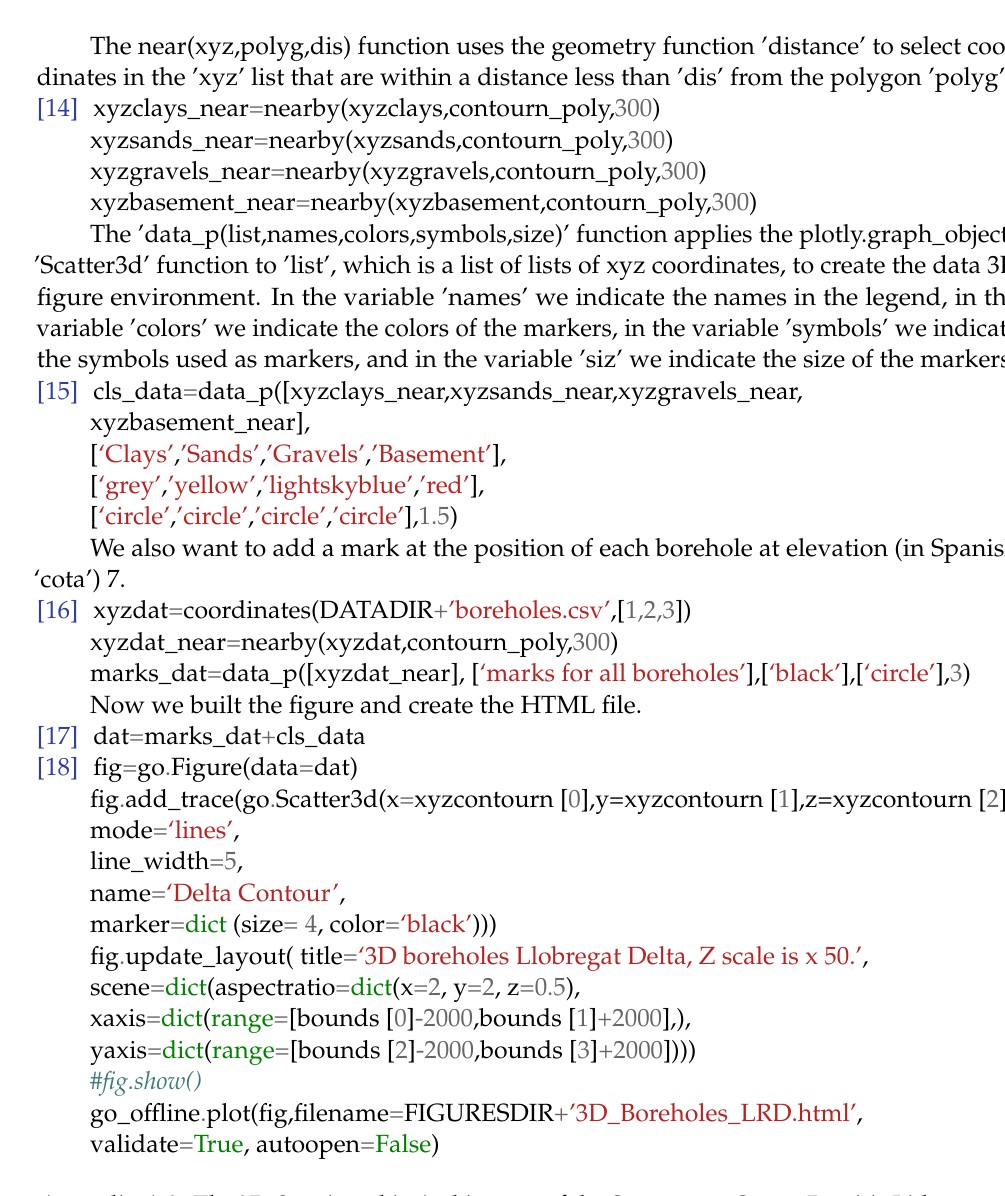
fig.update_layout( title=‘3D boreholes Llobregat Delta, Z scale is x